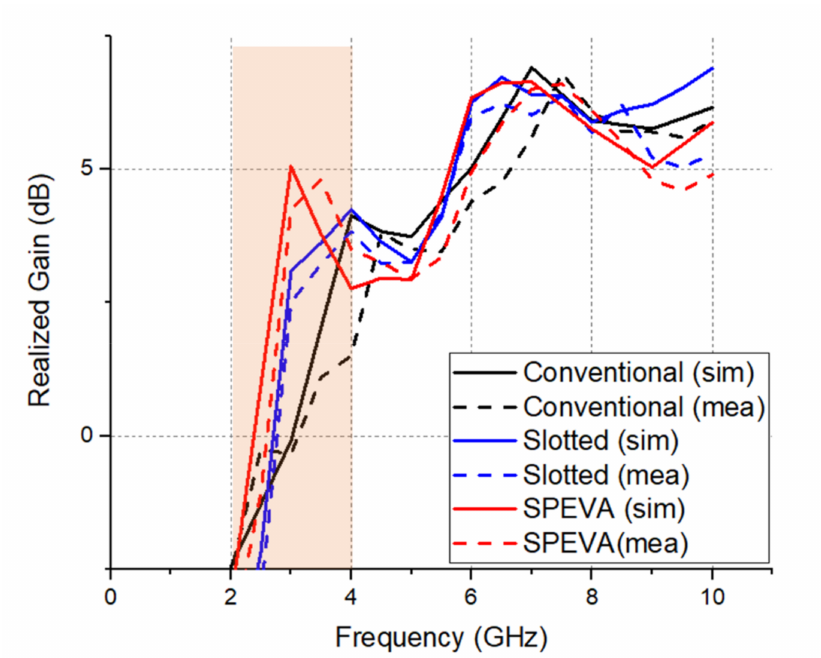
Figure7. SimulatedandmeasuredrealizedgainofthethreetypesofVivaldiantennas. Gainenhancement range is highlighted.